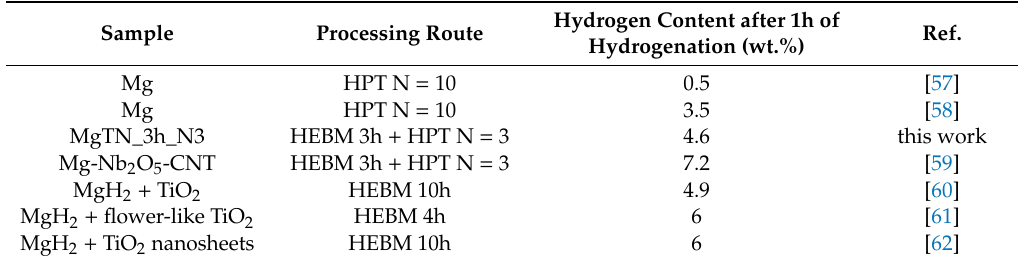
Table 2. Comparison of di ff erent Mg-based hydrogen storage